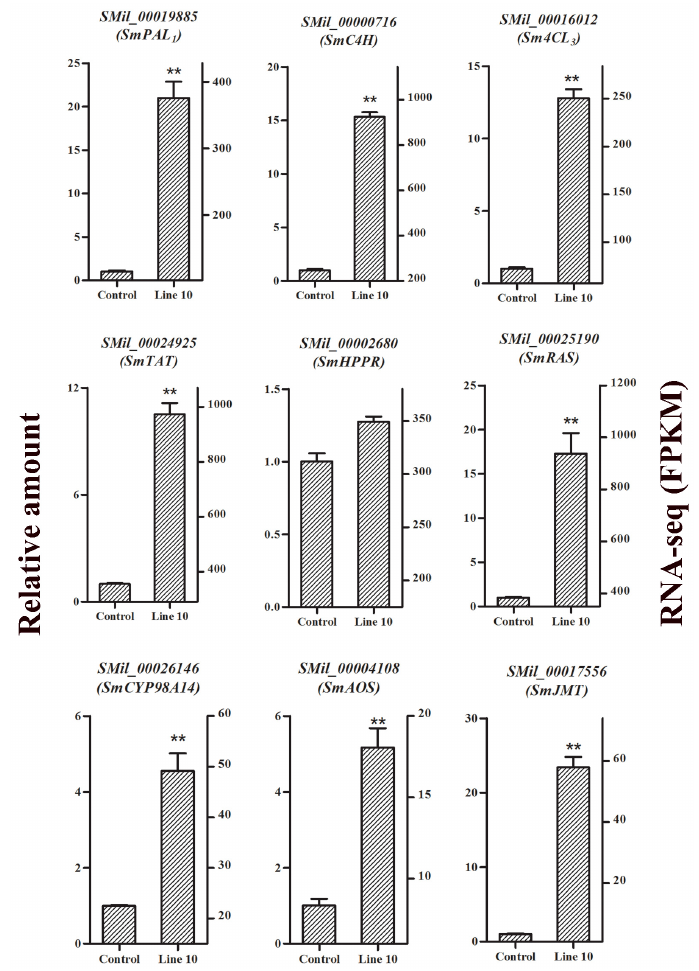
Figure 8. Validation by qRT-PCR of nine genes involved in the salvianolic acid biosynthesis and MeJA biosynthesis pathways in the control and transgenic line OEJ-10. All data are means of three replicates, with error bars indicating SD. ** Values are significantly different from the control at p < 0.01.